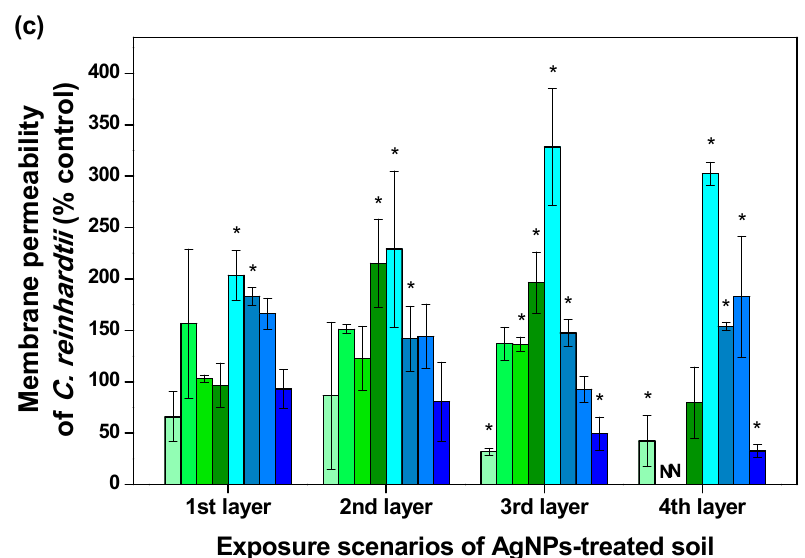
Figure 4. Physiological effects of Chlamydomonas reinhardtii dependent on the time and contamination configuration in soil treated with silver nanoparticles (AgNPs). ( a ) esterase activity, ( b ) oxidative stress, and ( c ) membrane permeability. Asterisks (*) represent results that are significantly different from the control ( p < 0.05). N stands for “not applicable” due to low cell density.